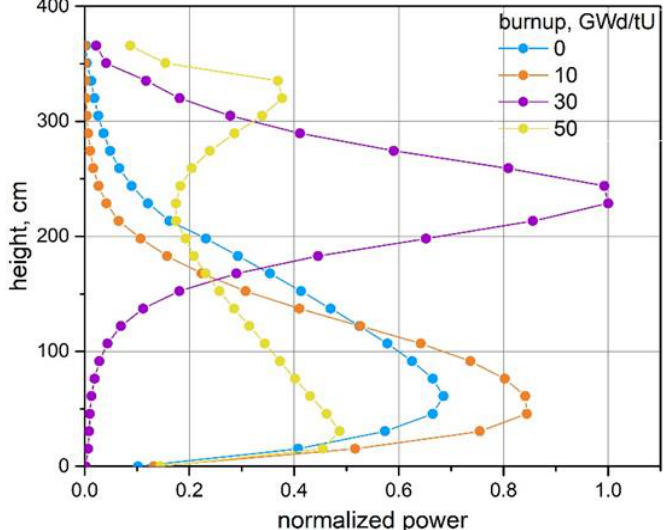
Figure 10. Power profile distribution for different burnups of the BWR assembly (M3 case).